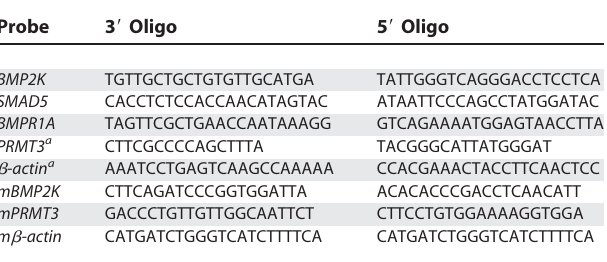
Table 1. Primer Sequences for Q-PCR and RT-PCR Probe